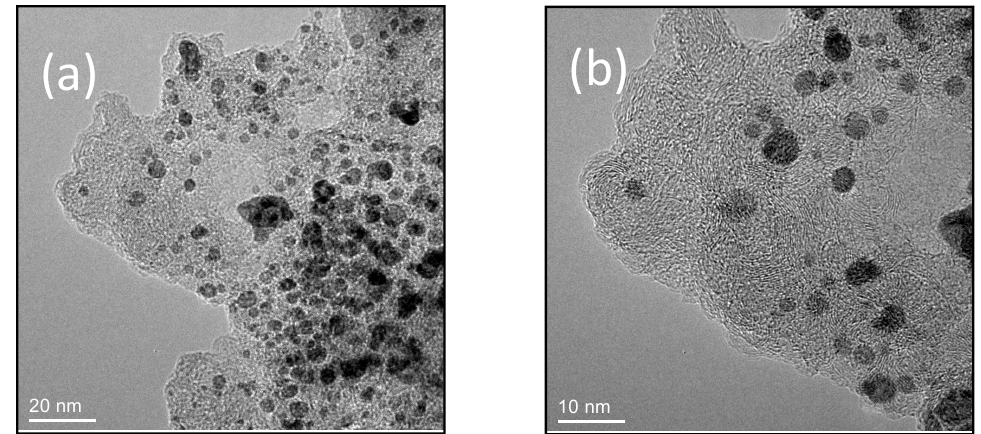
Figure 4. Transmission electron micrographs for CuPt / NC ( a ) 20 nm and ( b ) 10 nm.